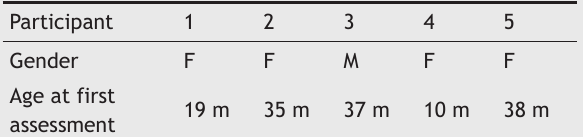
Table 2 Characterization of the control group regarding gender and age.